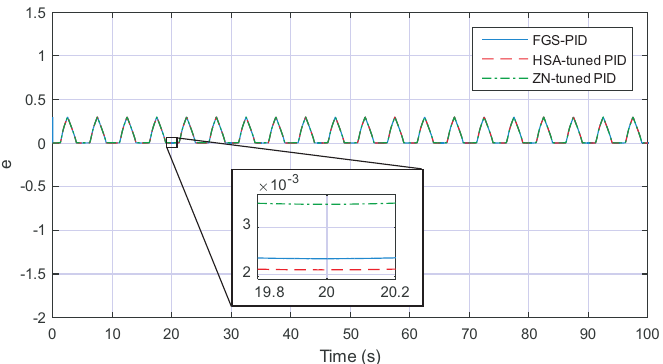
Figure 18. Error signal with different control methodologies in regular waves.